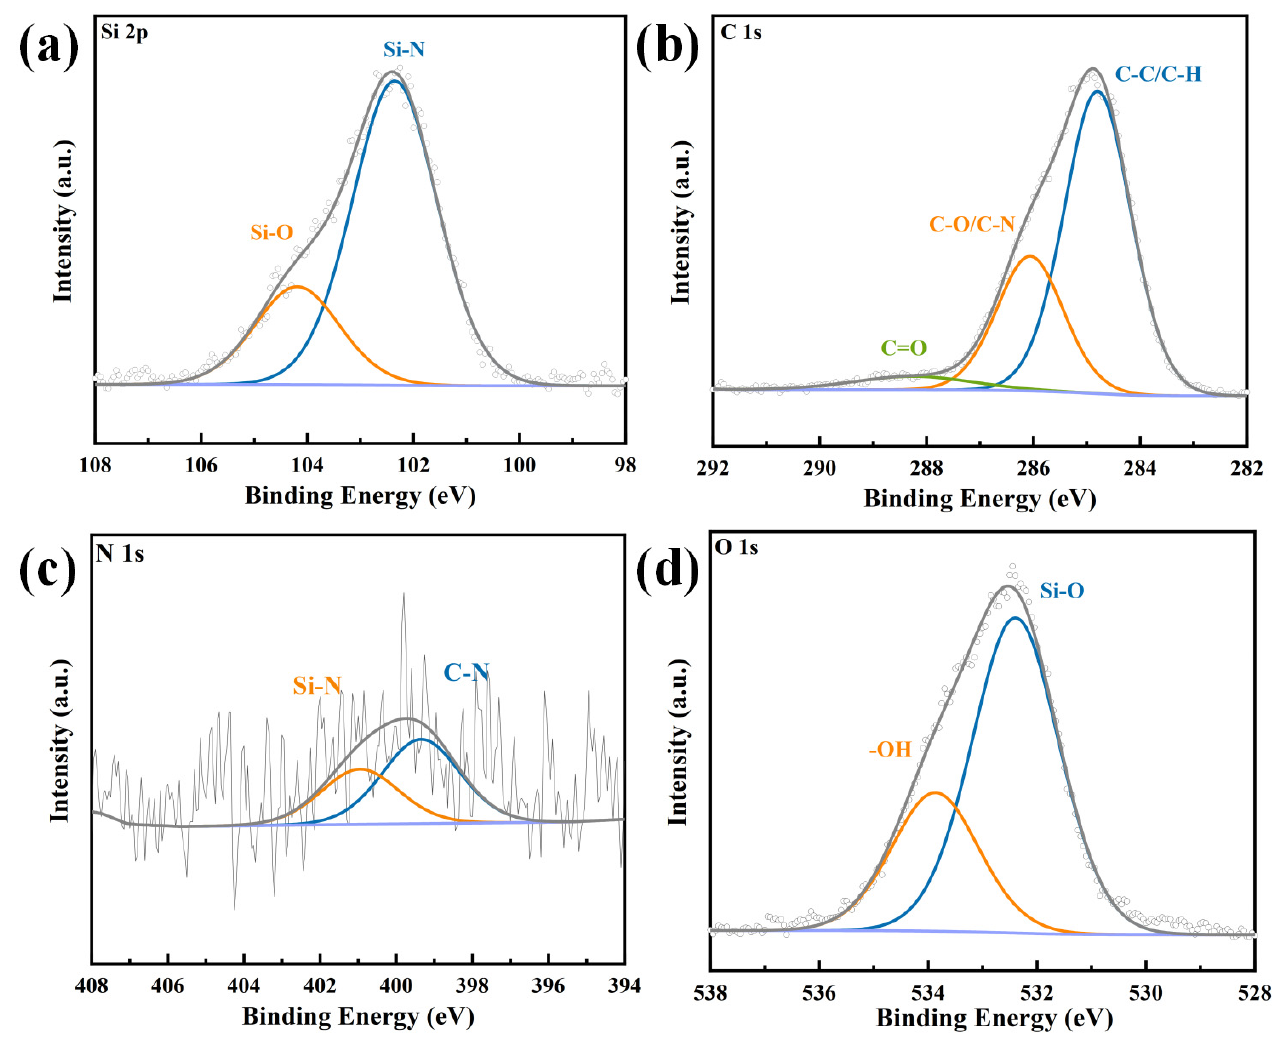
Figure 4. XPS spectra of the as-prepared DVB20-SiCN film. ( a ) Si 2P spectrum. ( b ) C 1s spectrum. ( c ) N 1s spectrum. ( d ) O 1s spectrum.